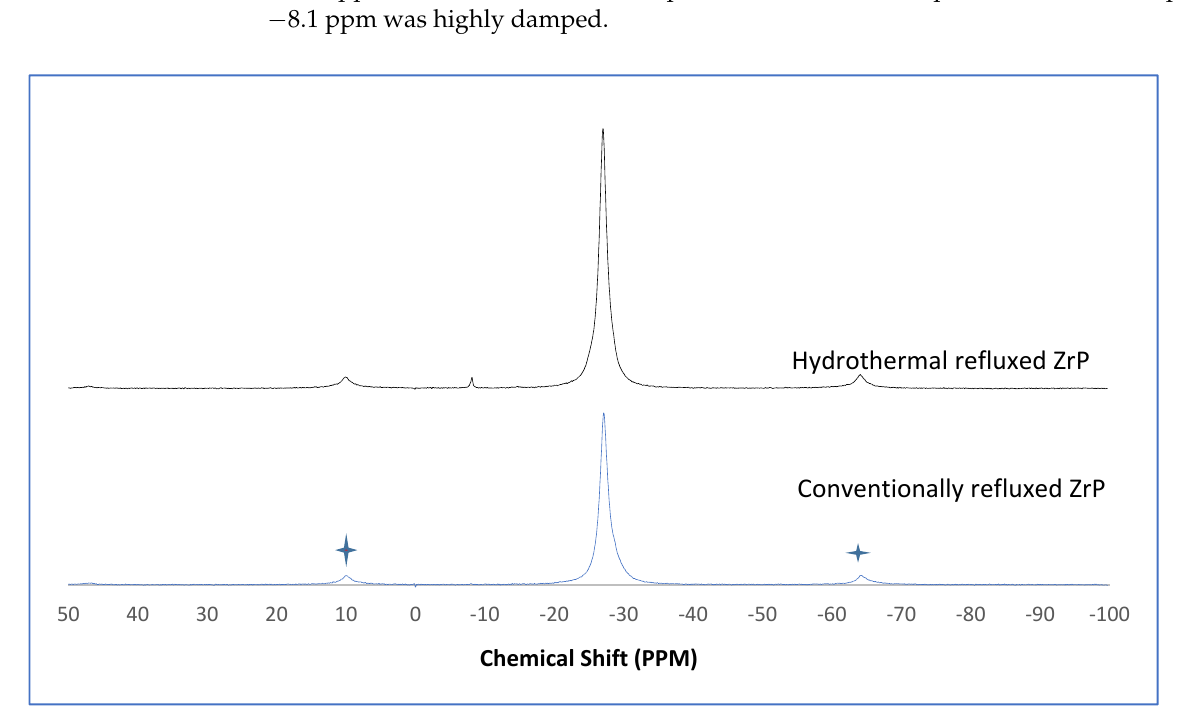
Figure 6. 31 P NMR of α -ZrP synthesised using the two described methods (spinning side bands are shown as ).